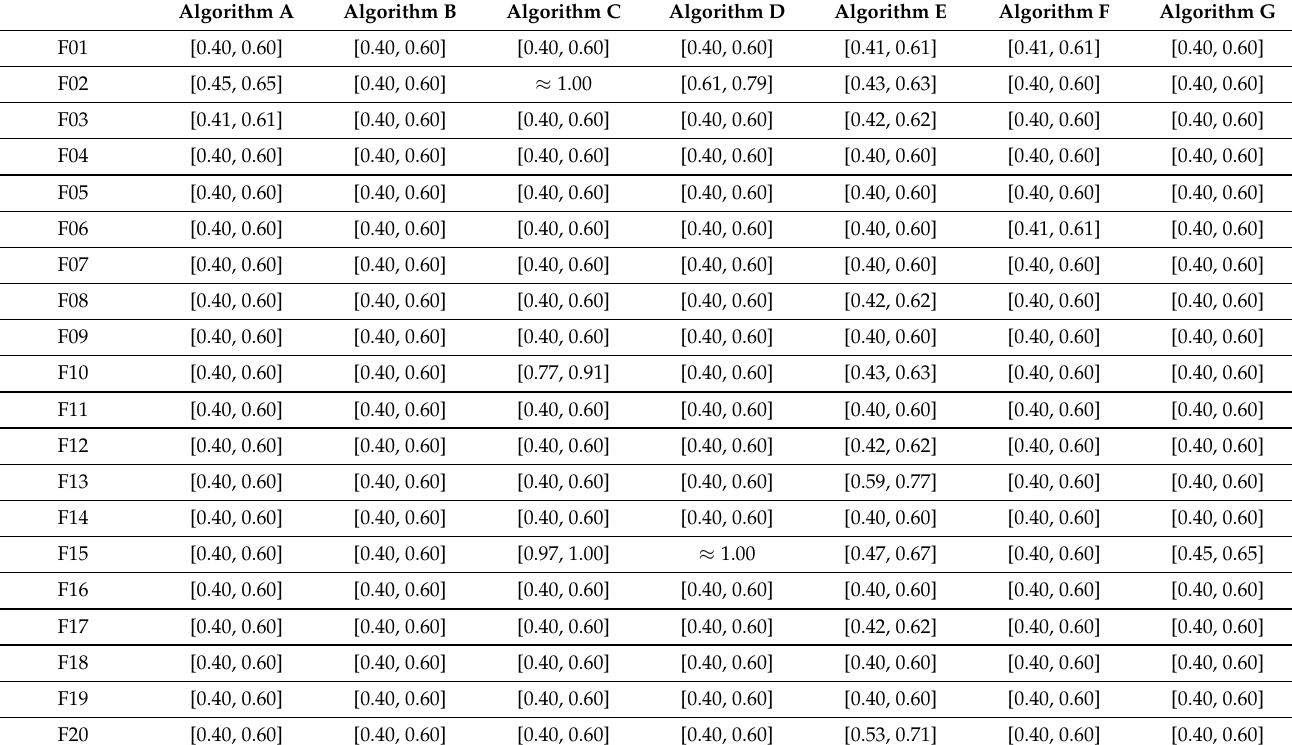
Table 13. Confidence intervals of the probability for sample quantiles Q 0.50 of solution